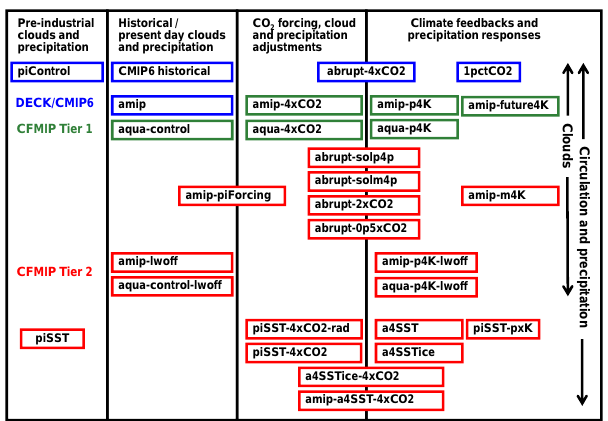
Figure 1. Summary of CFMIP-3/CMIP6 experiments and DECK + CMIP6 Historical